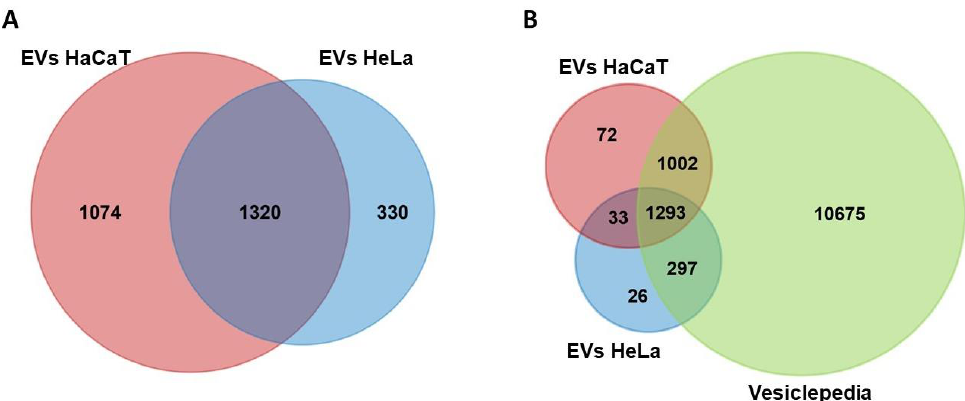
Figure 2. Venn diagrams of proteins identified in EVs: ( A ) comparison of proteins identified in EVs from HeLa and HaCaT cells; ( B ) comparison of proteins in EVs from HeLa and HaCaT cells included in the Vesiclepedia database.